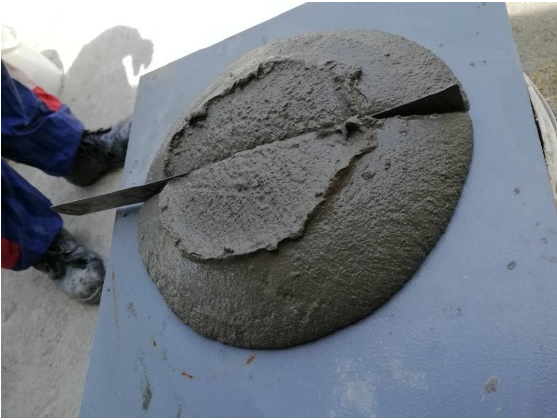
Figure 3. Slump test of fresh LFC.